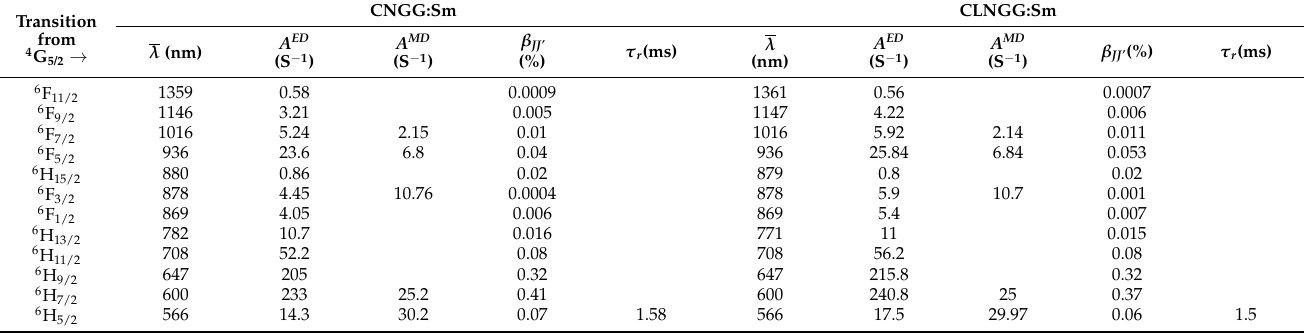
Table 3. Spontaneous emission probabilities ( A JJ’ ) , branching ratios ( β JJ’ ), and radiative lifetimes ( τ r ) of Sm 3+ ions in CNGG:Sm and CLNGG:Sm crystals. (Reprinted with permission from Ref. [21], copyright 2017,